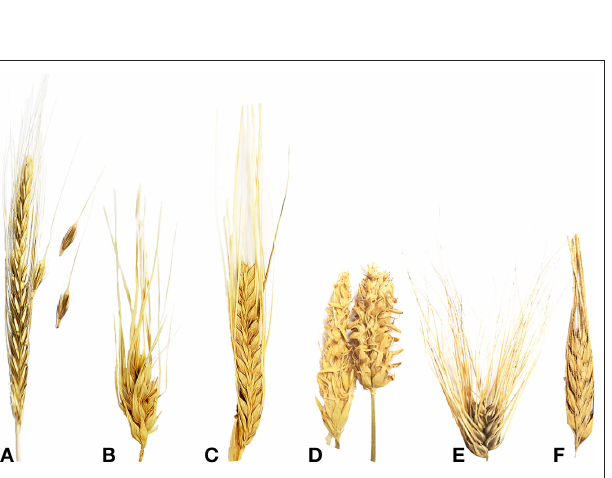
FIGURE 9 | An example of highly diverse barley varieties: (A) wild two-row, (B) six-row naked, (C) two-row hulled, (D) hooded-naked, (E) six-row lax-eared naked, and (F) two-row hulled